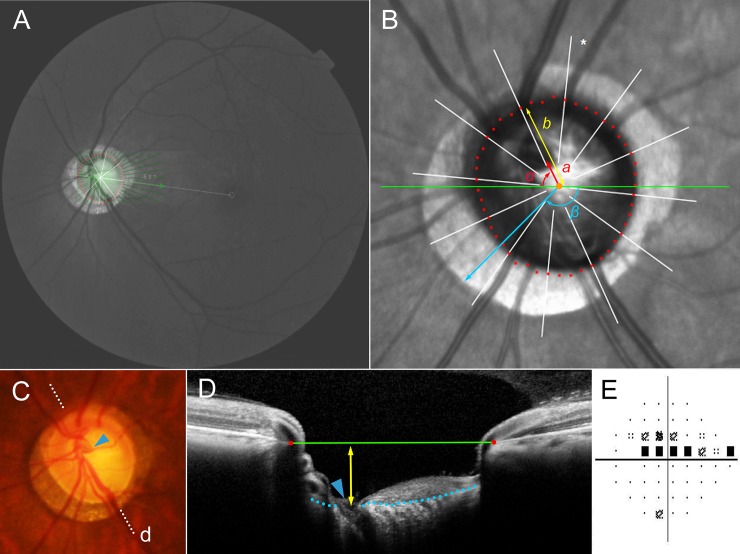
Measurement of position of central vascular trunk as surrogate of lamina cribrosa (LC) shift.(A) Red-free fundus photo. Diffuse retinal nerve fiber layer (RNFL) loss was observed in both hemispheres but was more severe in the inferior hemisphere. An infrared image obtained by spectral-domain optical coherence tomography (SD-OCT) is transposed to show the margin of the Bruch’s membrane opening (BMO) and the foveal-BMO axis. SD-OCT uses 24 radial scan images to delineate the BMO margin (red dots) and calculate the foveal-BMO axis. (B) Magnified view of peripapillary area. The red dots indicate the BMO margin, and the green line is the reference line. The angular deviation of the vascular trunk (α) is measured clock-wise, with the nasal horizontal midline as 0°. A positive value indicates the superior location, and a negative value indicates the inferior location relative to the reference line. From the BMO center, the distances are measured to the vascular trunk (a), and to the BMO margin in the same direction (b). The ratio of these distances is defined as the ‘shift index’ (a/b), which is used to measure the extent of shift. The angular location of maximum width of β-zone parapapillary atrophy (PPA) (β) is measured clock-wise from the reference line (green line), with the temporal horizontal midline as 0°. A positive value indicates the superior location and a negative value indicates the inferior location relative to the reference line. (C) Disc photograph. The dotted line indicates the location of the SD-OCT scan, targeted to the central retinal vascular trunk (arrowhead). (D) Cross-sectional image of SD-OCT clearly showing emergence of central retinal vascular trunk (arrowhead). The LC depth is measured as the vertical distance from the BMO plane (green reference line) to the vascular trunk (yellow double arrows). The blue-dotted line indicates the anterior LC surface margin. (E) The Humphrey visual field result shows scotoma only in the superior hemisphere.